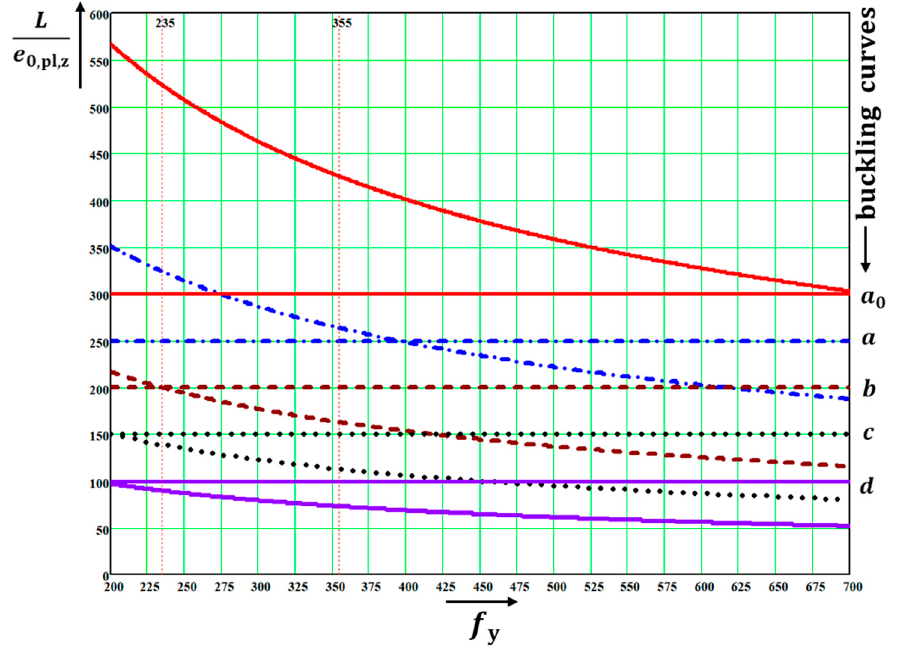
Figure 22. Comparison of horizontal lines [7] to the curves [18] defining bow imperfection 𝑒 (cid:2868),(cid:2926)(cid:2922),(cid:2936) .